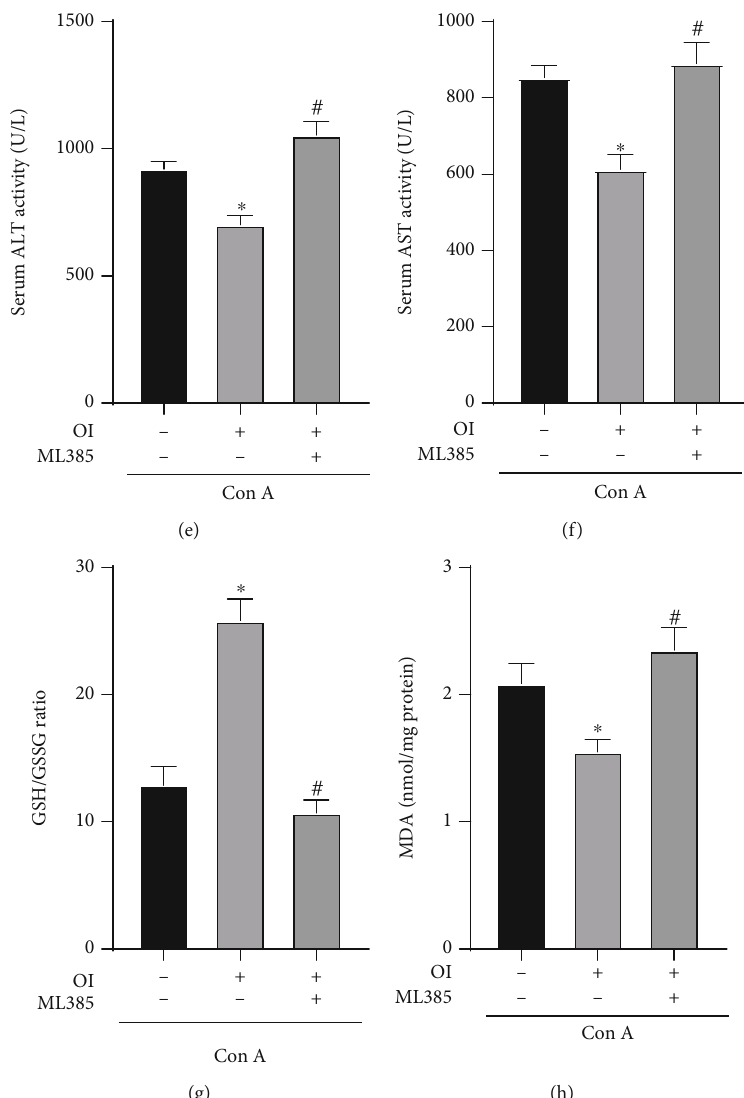
Figure 5: Protective e ff ect of OI was decreased by ML385 in Con A-induced liver injury. (a, b) Immunohistochemical assay of c-PARP was evaluated in hepatic tissues in each group. (c, d) The hepatocyte apoptosis was evaluated in hepatic tissues in each group by TUNEL assay. The (e) serum ALT and (f) serum AST activities were evaluated in each group in mice. To evaluate the oxidative stress, the (g) GSH/GSSG ratio and (h) MDA level were measured in each group. Data are expressed as mean ± SEM ( n = 6 ). ∗ p < 0 : 05 vs. Con A group. # p < 0 : 05 vs. Con